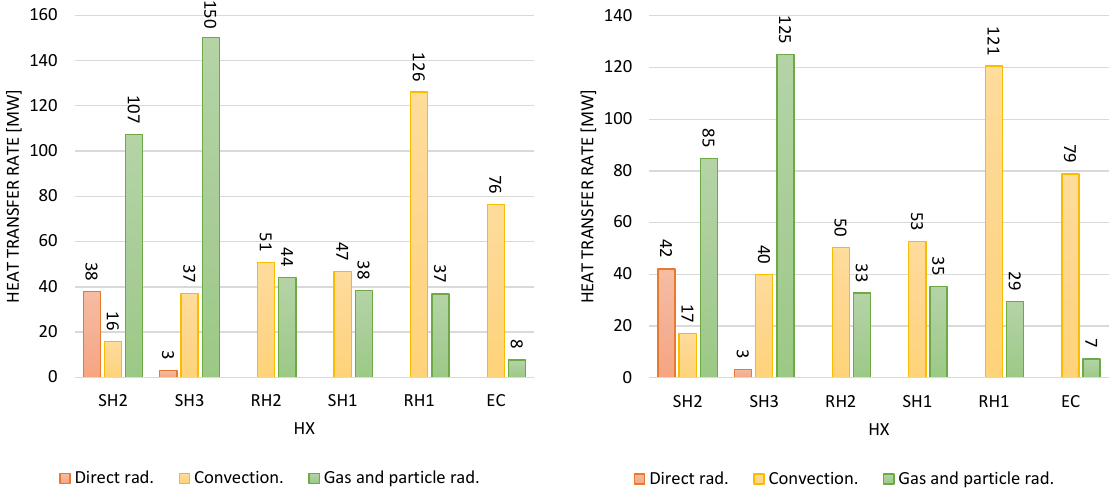
Figure 8. Breakdown of heat transfer rates per mechanism for M1 ( left ) and M2 ( right ) for the utility-scale coal-fired boiler model.